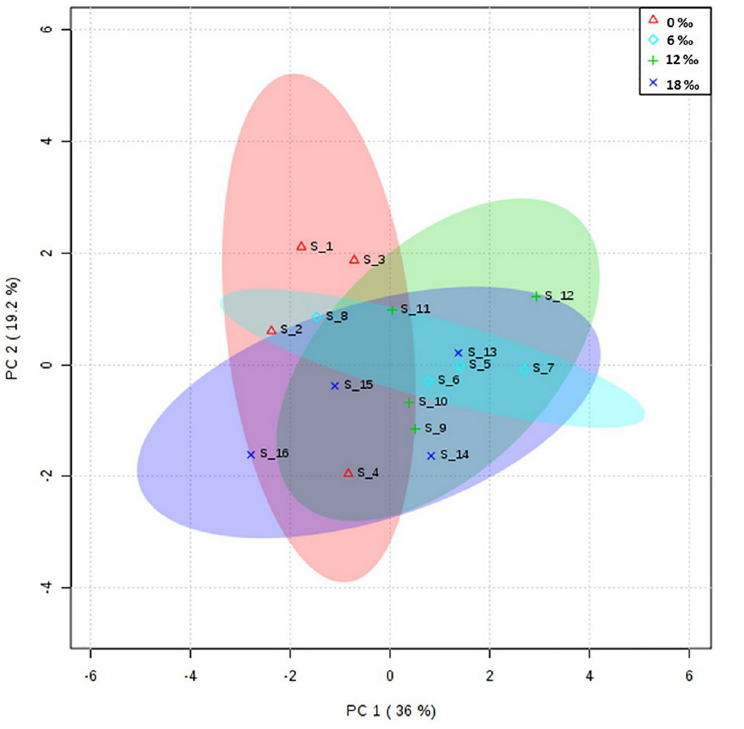
Fig 5. PCA scores plot of fatty acids profiles in the muscles of adult male E . sinensis . https://doi.org/10.1371/journal.pone.0219260.g005 Table 6. The principal fatty acid profiles (% total fatty acids) of the neutral lipids and polar lipids in the muscles of adult male E . sinensis .